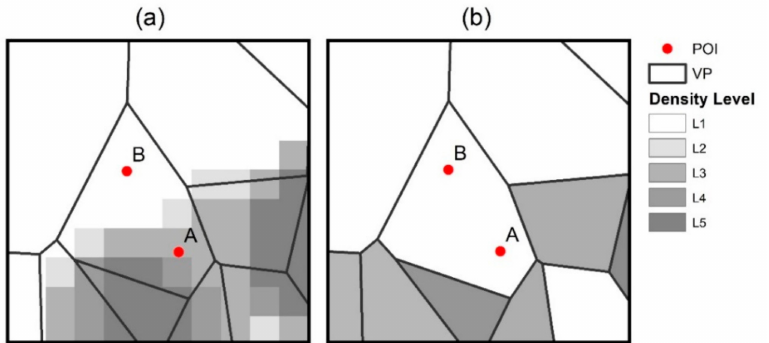
Figure A3. Comparison of two strategies of using density distributions. ( a ) illustrates an example of S2, while ( b ) shows the corresponding case of